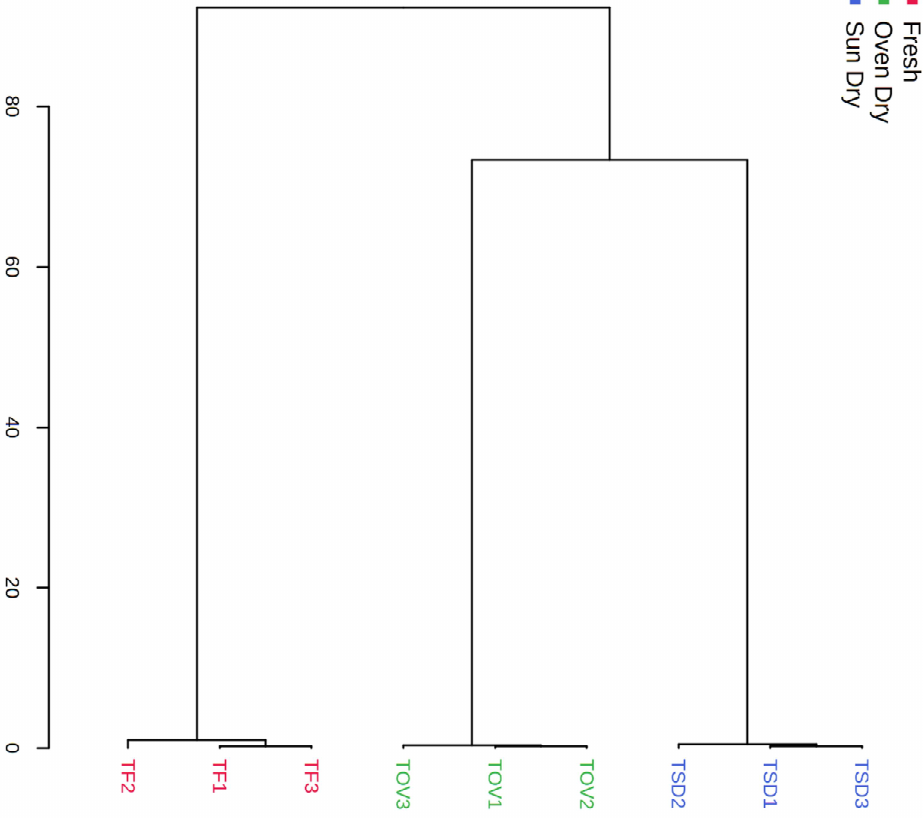
Figure 7. The dendrogram represents the cluster analysis after heat treatment done on the Thailand ginger